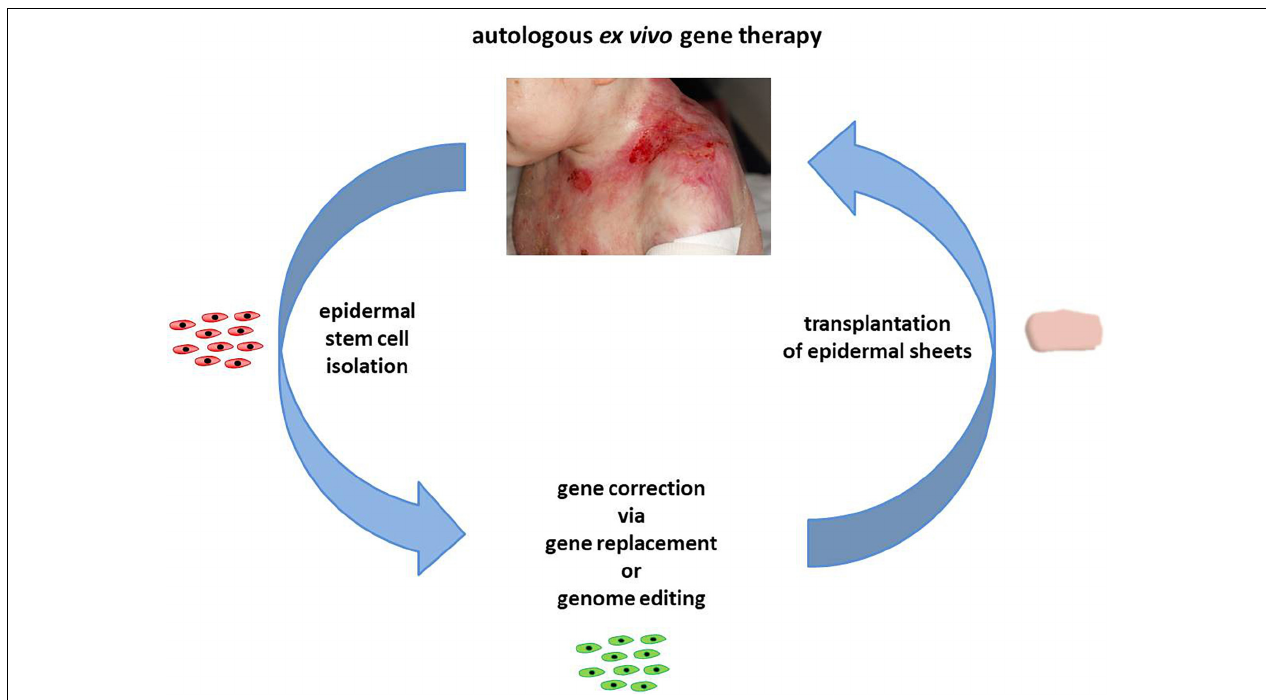
FIGURE 1 | Autologous ex vivo gene therapy. In the course of an autologous ex vivo gene therapy, epidermal stem cells are initially isolated from a skin biopsy of a patient. Upon gene correction via gene replacement or genome-editing strategies, the genetically corrected cells are expanded to epidermal sheets, which are subsequently transplanted back onto the patient. Images courtesy of Rudolf